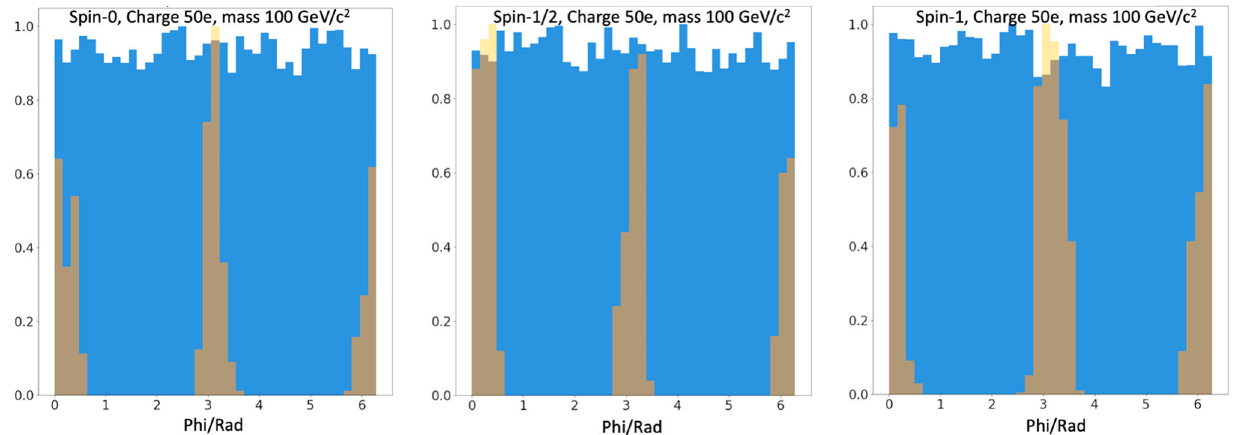
Fig. 17 The phi angle distribution for HECOs of mass 100 GeV/c 2 with electric charge 50 e , produced via the DY process with virtual pho- ton exchange, for each spin assignment. In each case, 60K events were